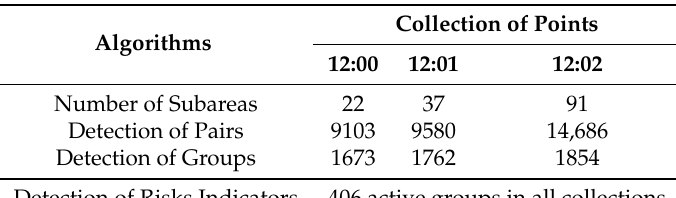
Table 13. Results of the algorithms’